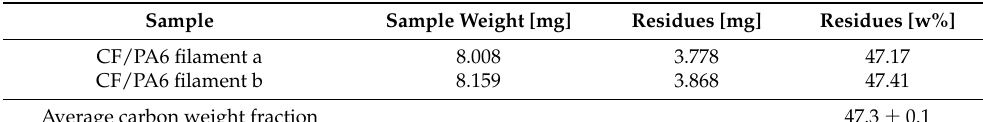
Table 2. Results of the CF residues after the TGA measurement (up to 600 °C), which are used to calculate the fiber ratio in the CF/PA6